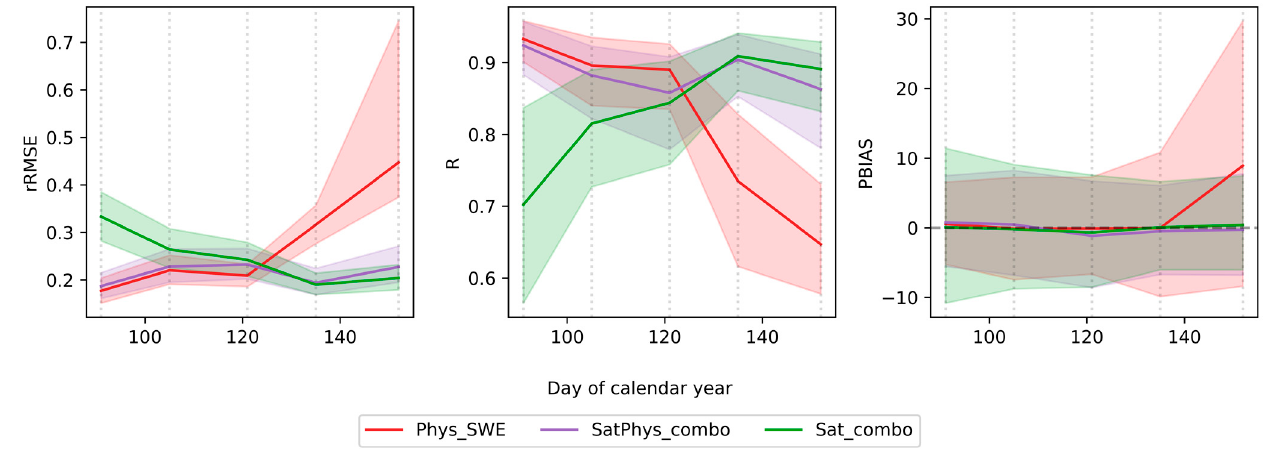
Figure 5. The median relative RMSE, rRMSE, correlation, R, and PBIAS statistics for three di ff erent satellite and in-situ-based water supply forecasts in the East R. basin with interquartile range (25/75 percentiles) shaded. Vertical do tt ed lines denote the days chosen for forecasting—1 April, 15 April,